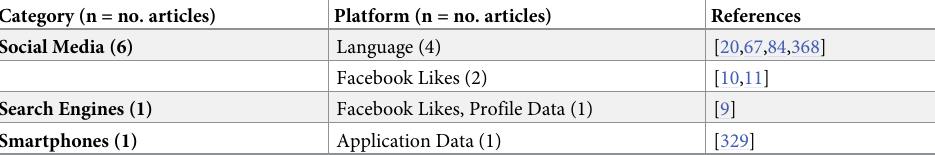
Table 22. Number of articles predicting religion, with associated predictors and references.